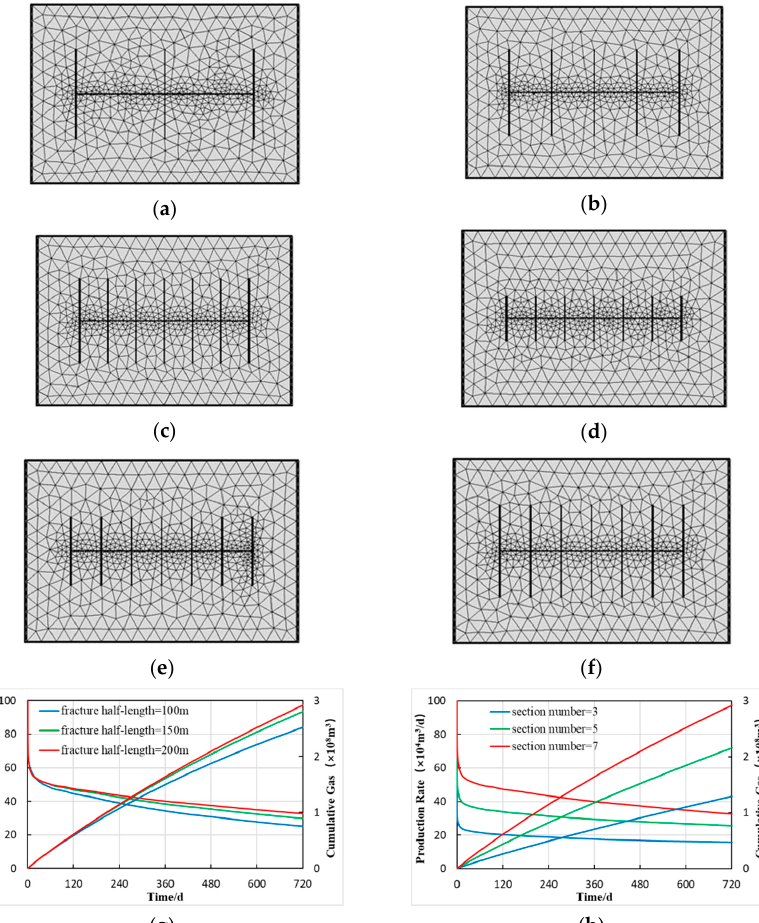
Figure 12. The effect of horizontal well parameters on productivity. ( a ) section number = 3; ( b ) section number = 5; ( c ) section number = 7; ( d ) fracture half-length = 100 m; ( e ) fracture half-length = 150 m; ( f ) fracture half-length = 200 m; ( g ) Three fractured sections, T = 5a; ( h ) Four fractured sections, T = 5a.